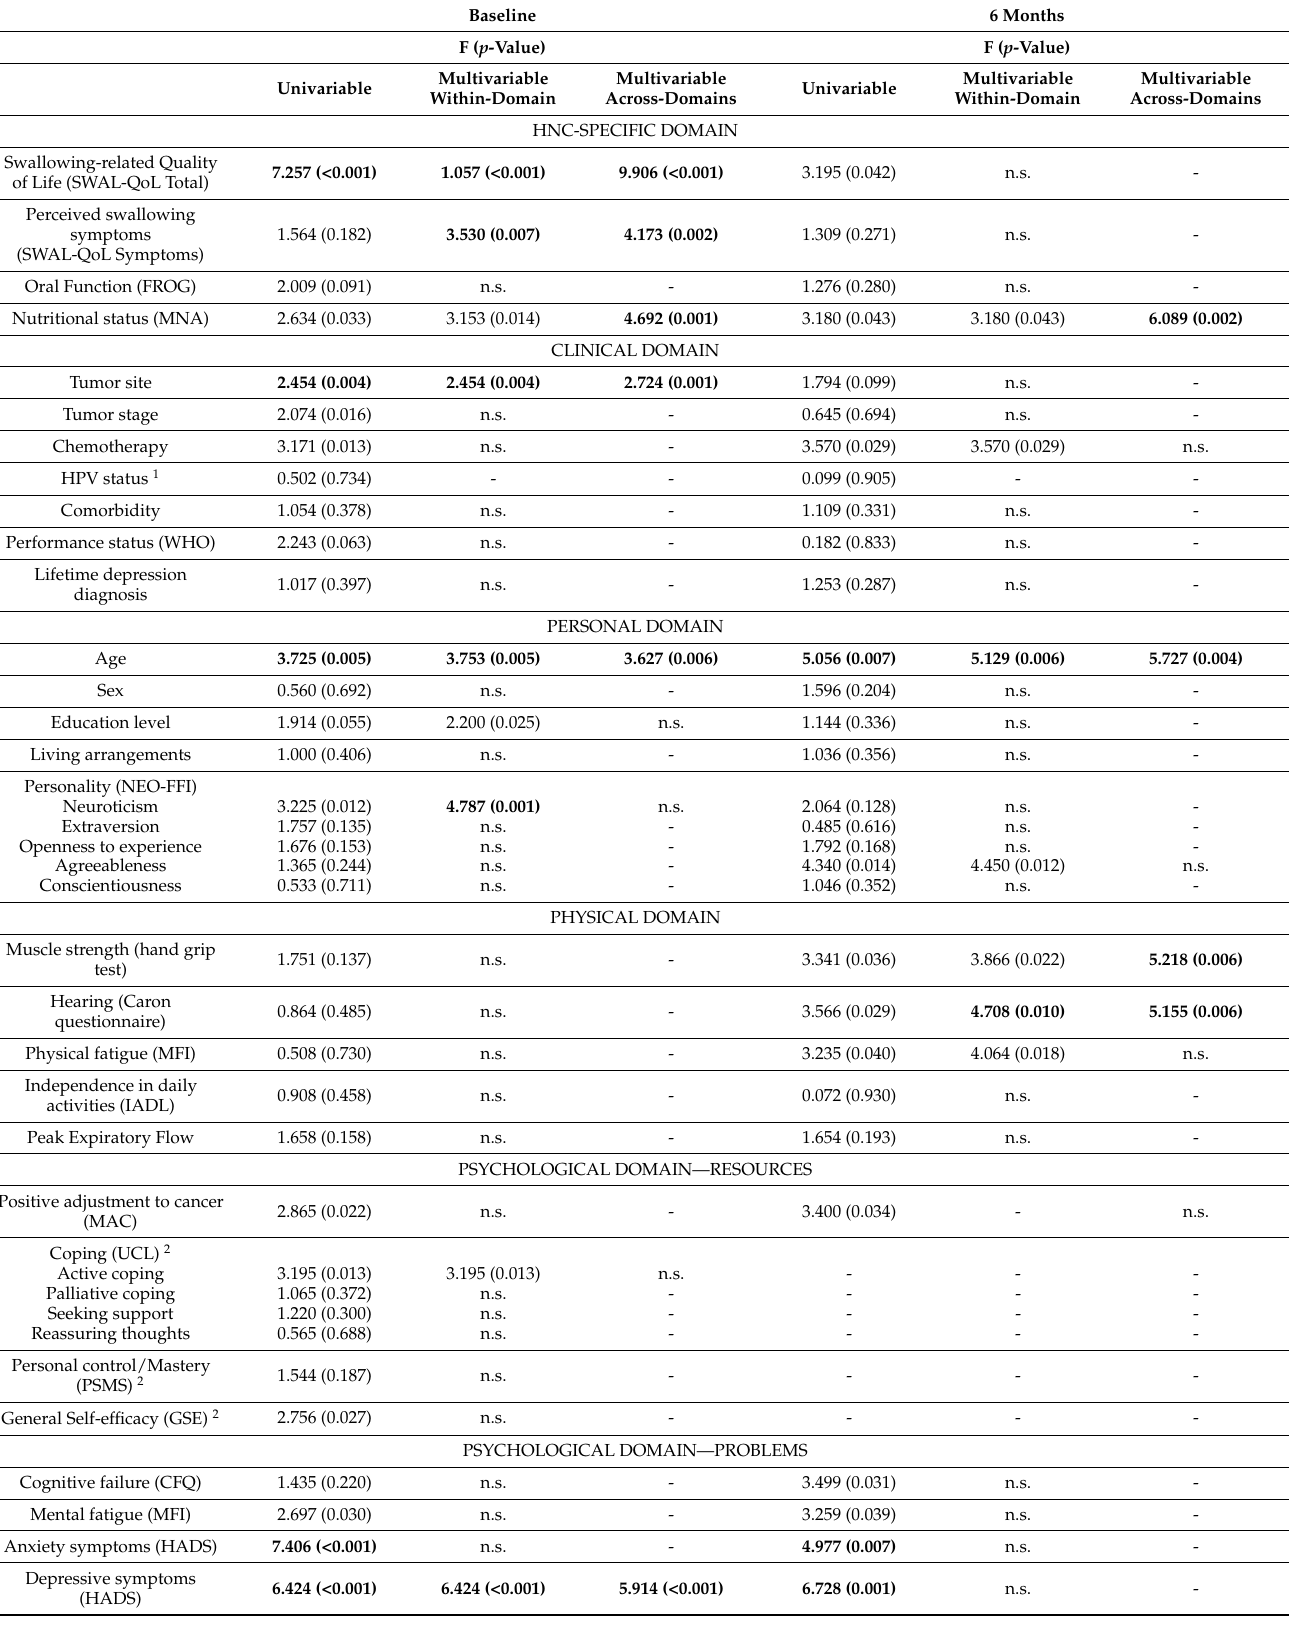
Table 3. Associations between social eating problems (EORTC H&N35) up to 24-month follow-up and baseline and 6 months post-treatment